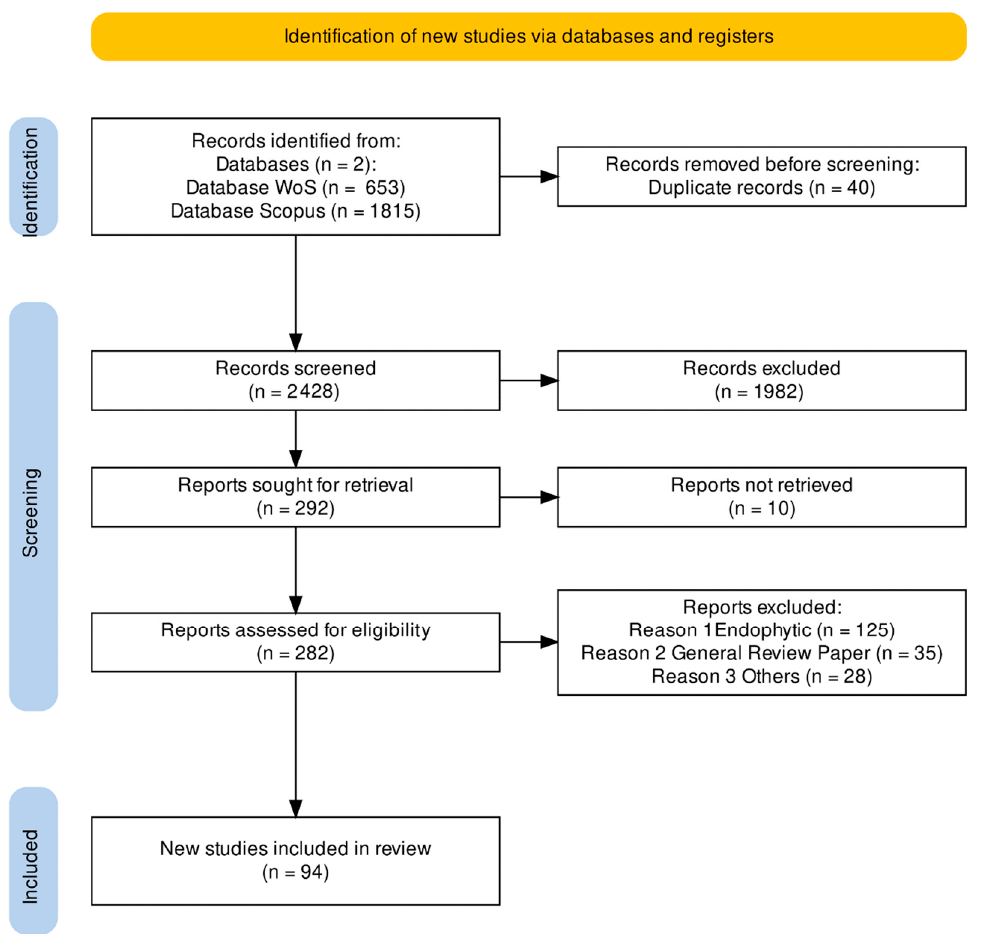
Figure 3. Preferred reporting items for systematic reviews and meta-analyses (PRISMA) flow diagram, generated using searches on the Web of Science (WoS) and Scopus databases. The figure was drawn using PRISMA2020 flow diagram R package [46].